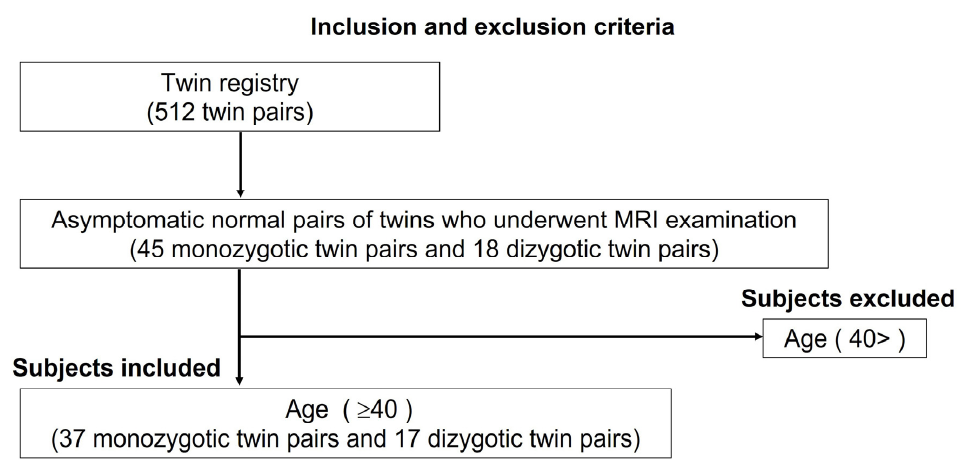
Figure 1. Inclusion and exclusion criteria for subjects.